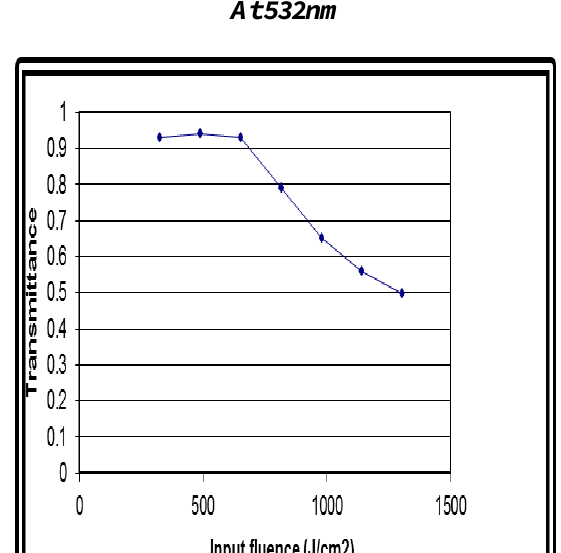
Fig.12: The optical limiting behavior of nanostructure copper oxide thin film. At 532nm